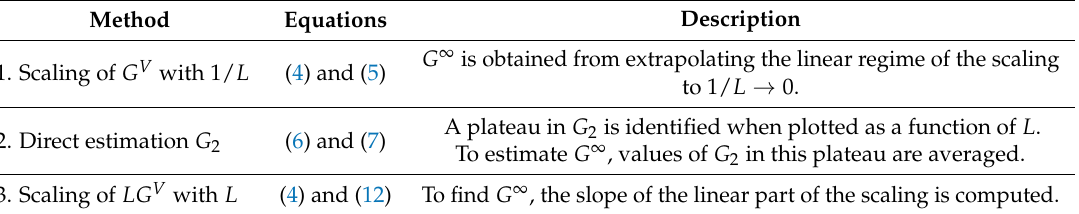
Table 1. A brief description of the methods used in this work to estimate Kirkwood–Buff (KB) integrals in the thermodynamic limit G ∞ using radial distribution functions (RDFs) computed from finite systems.